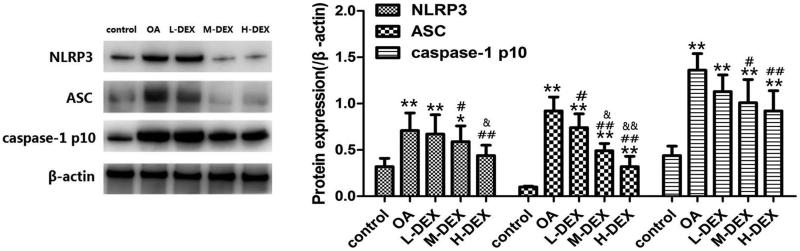
Effect of Dex on NLRP3 inflammatory bodies in OA rats. The expression levels of NLRP3, ASC and caspase-1 in cartilage tissues were detected by Western blotting. Values are means ± SD. N = 10. **p < 0.01 vs. control group; #p < 0.05, ##p < 0.01 vs. OA group; &p < 0.05, &&p < 0.01 vs. L-DEX group.